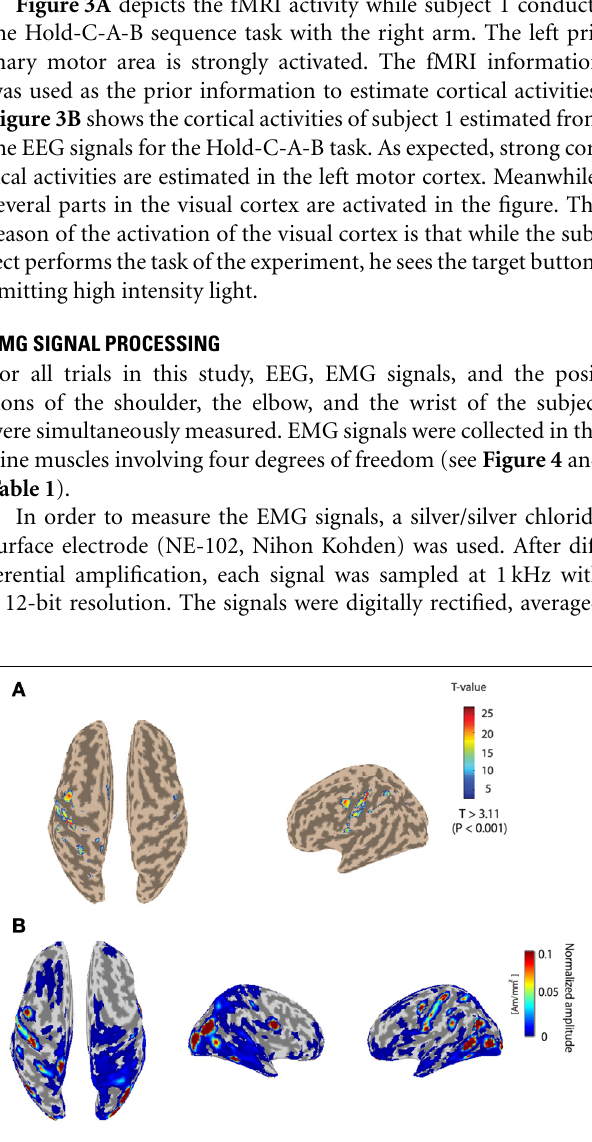
FIGURE 3 | (A) The fMRI activity while subject 1 performs the Hold-C-A-B sequence task. (B) Estimated cortical activities of subject 1 for the task of the Hold-C-A-B sequence (an average of 70